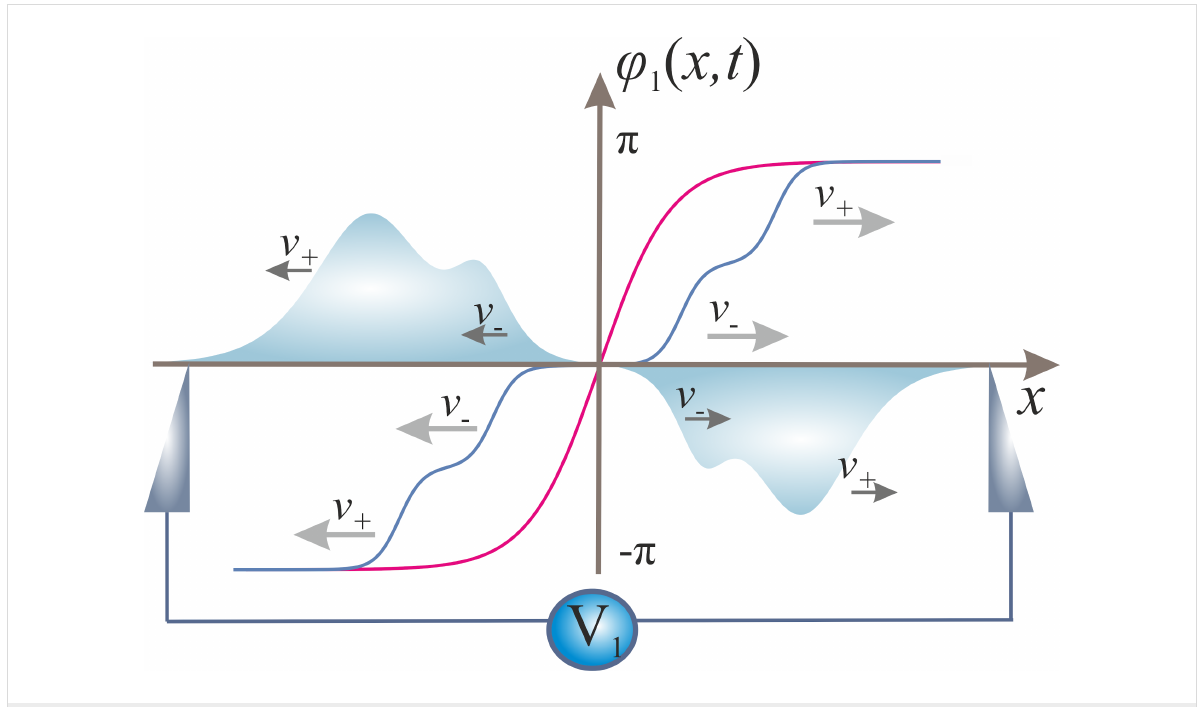
Figure 3: The same as in Figure 1 in the first of the two capacitively coupled superconducting nanowires. Each of the voltage pulses is split into two propagating with different velocities v ± .